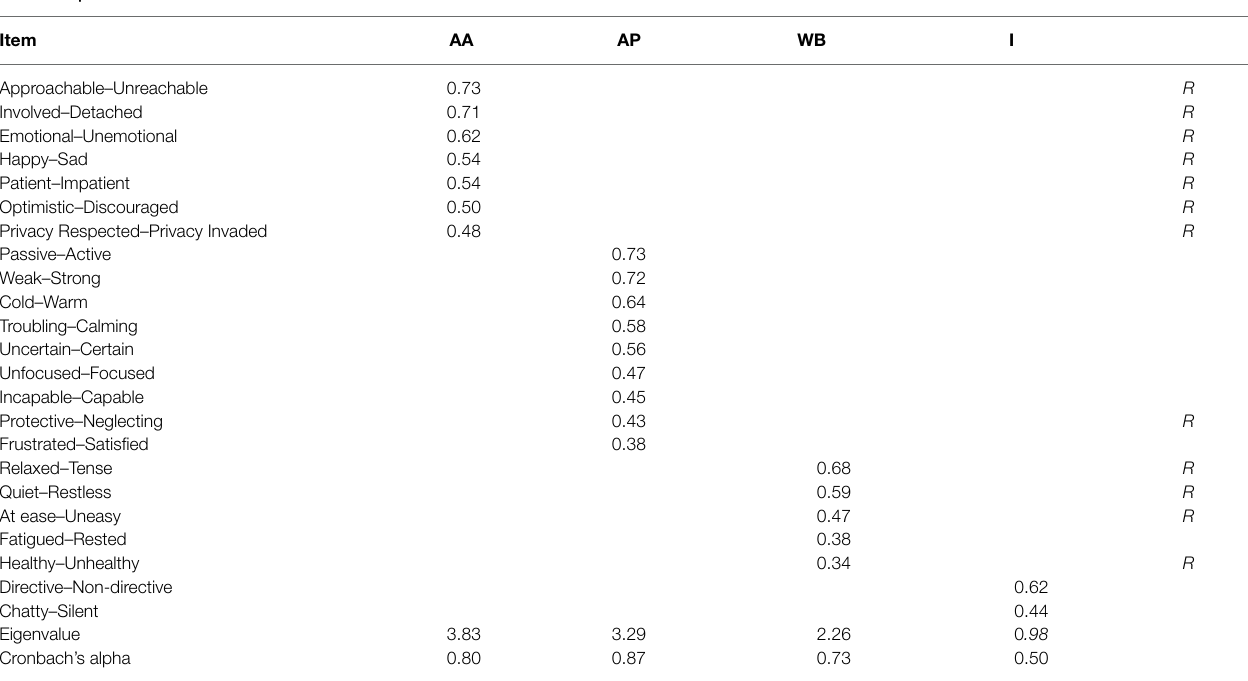
TABLE 1 | Semantic differential items and factor